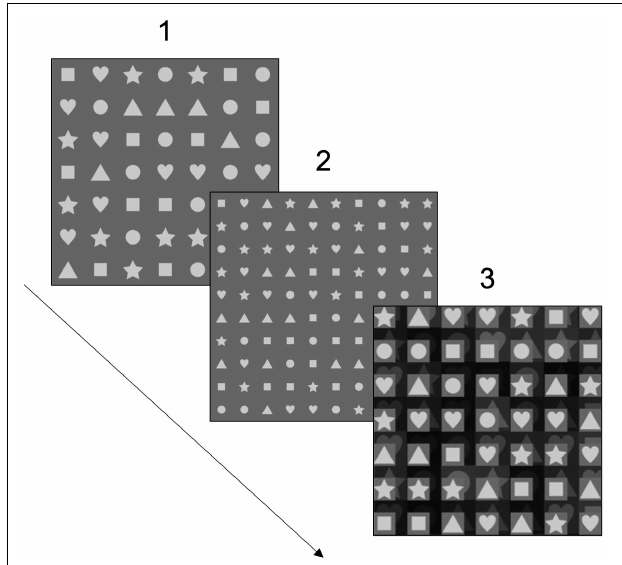
FIGURE 1 | A representation of the Rapid Automatized Naming (RAN)-Shapes task. A first 7*7 matrix (1) to name is delivered to participants, followed by a second 10*10 matrix (2), which is more difficult because of the smaller shapes to identify, and by a third 7*7 matrix (3), which is characterized by background visual interference. For each matrix, 30 s are given to participants to name as many shapes as possible